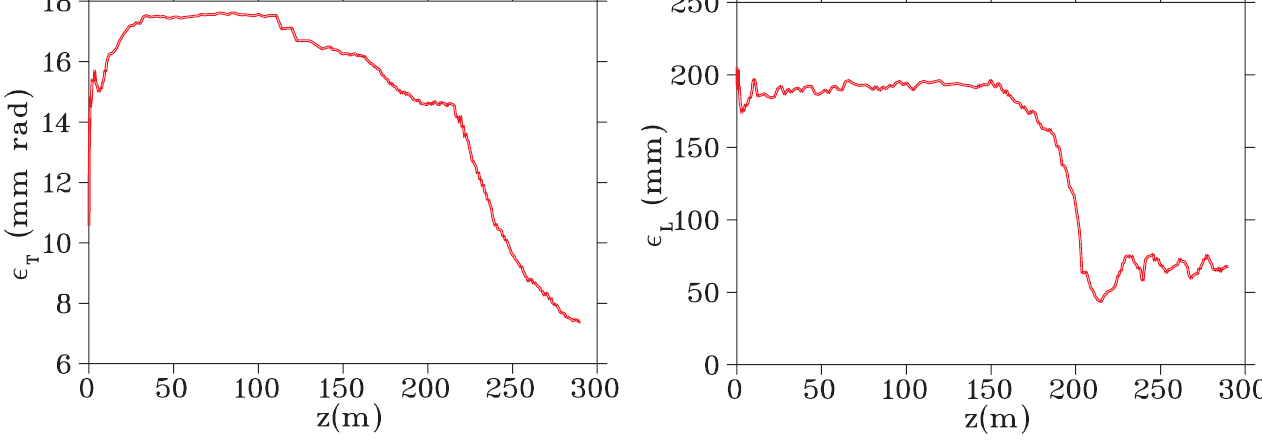
FIG. 14. (Color) Normalized transverse emittance (left) and longitudinal emittance (right) along the front end for a momentum cut 0 : 1 (cid:10) p (cid:10) 0 : 3 GeV =c .